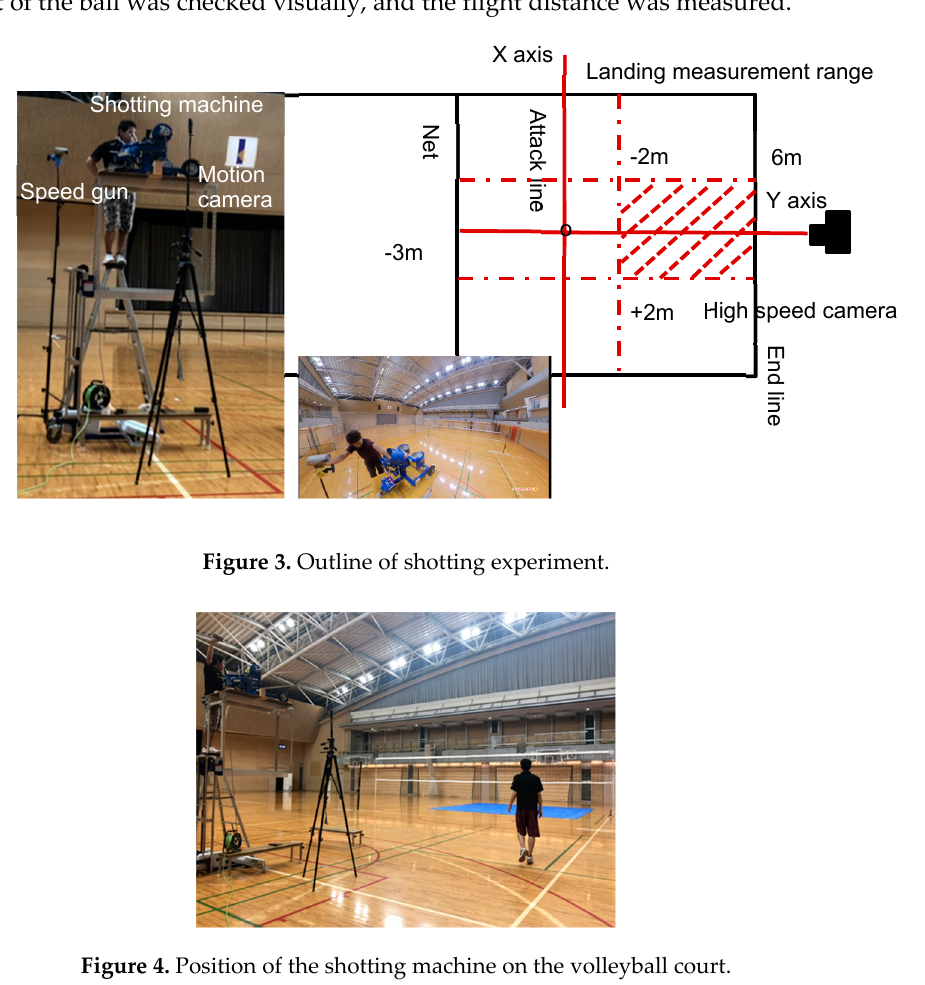
Figure 4. Position of the shotting machine on the volleyball